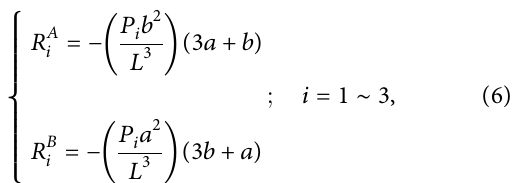
Figure 4, and the equivalent nodal forces components at